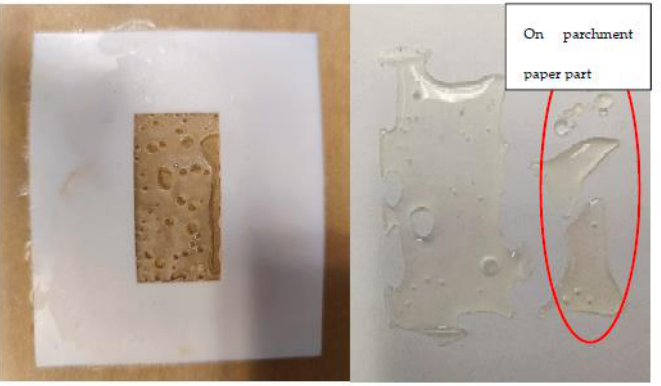
Figure 10. Fragile sample remaining in the mold cavity with holes ( left ) and adhesion to the release liner ( right ).